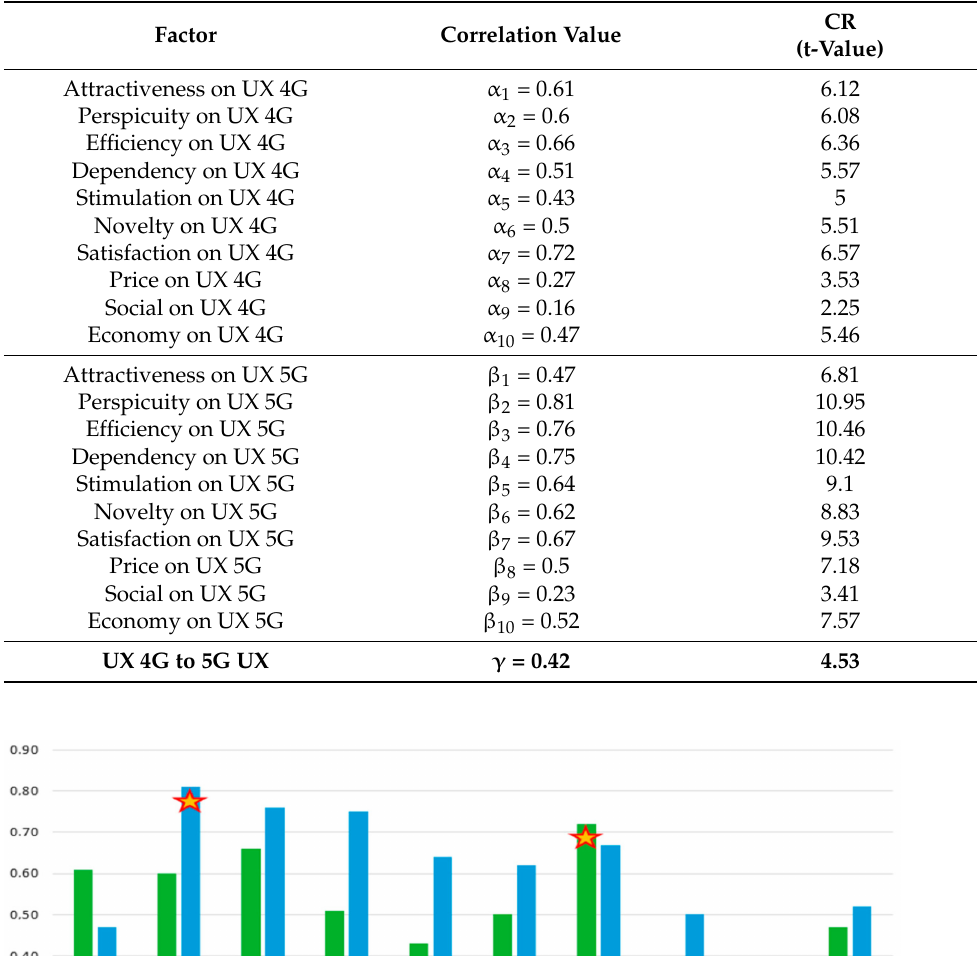
Table 2. Correlation values for UX video streaming in Indonesia.